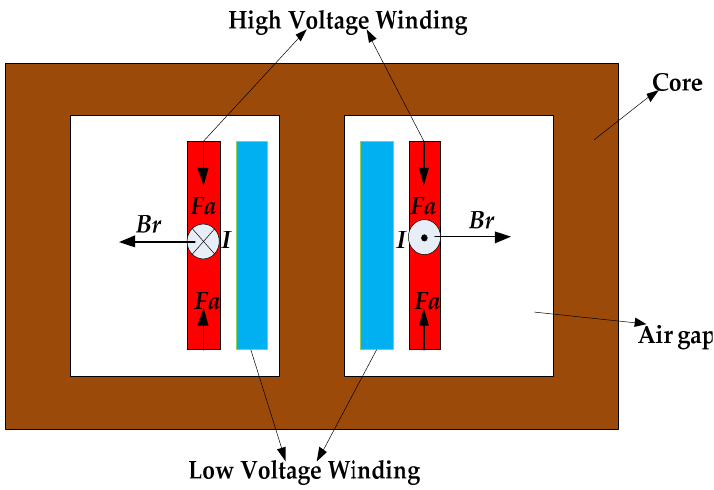
Figure 6. The axial force generated in the winding under the inrush current.